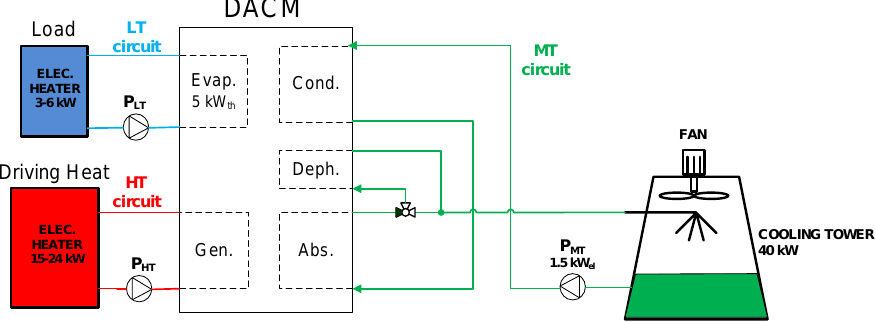
Figure 3. Simplified hydraulic scheme of the experimental